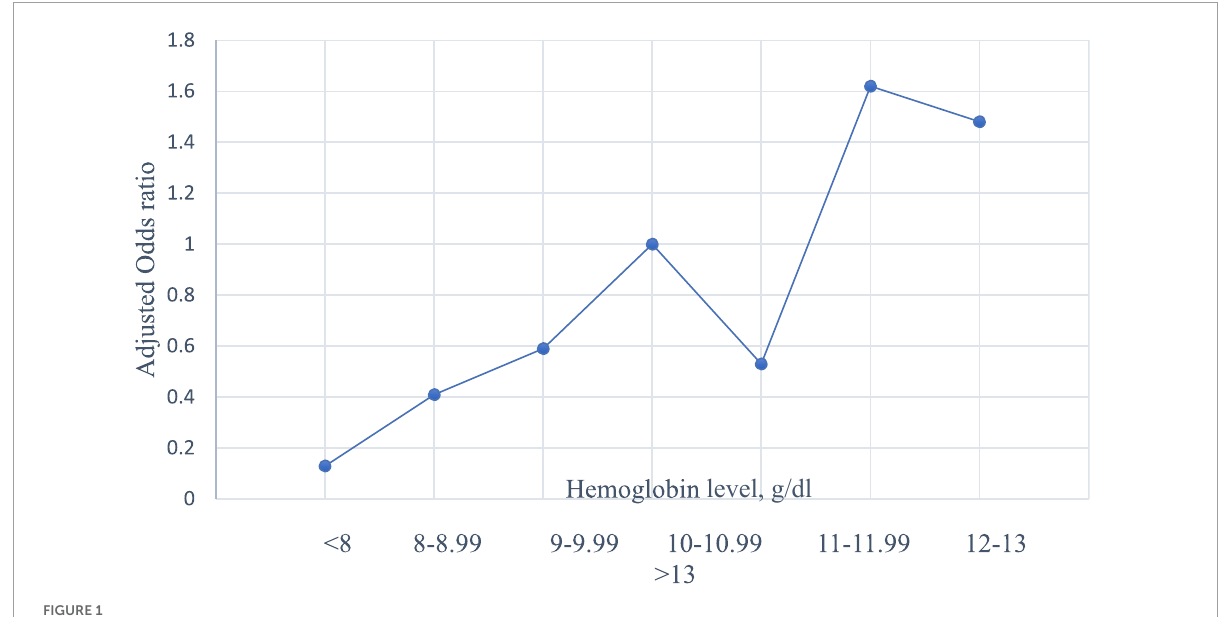
FIGURE1 The adjusted odds ratio of haemoglobin level and preterm birth in Khartoum, Sudan 2020.